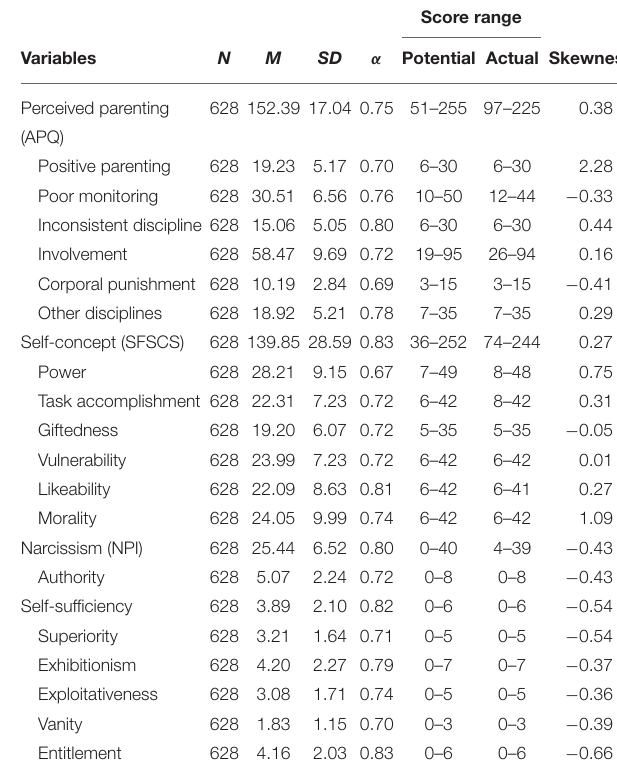
TABLE 2 | Descriptive statistics of Alabama Parenting Questionnaire (APQ), Narcissistic Personality Inventory, and Six Factor Self Concept Scale (SFSCS) and their